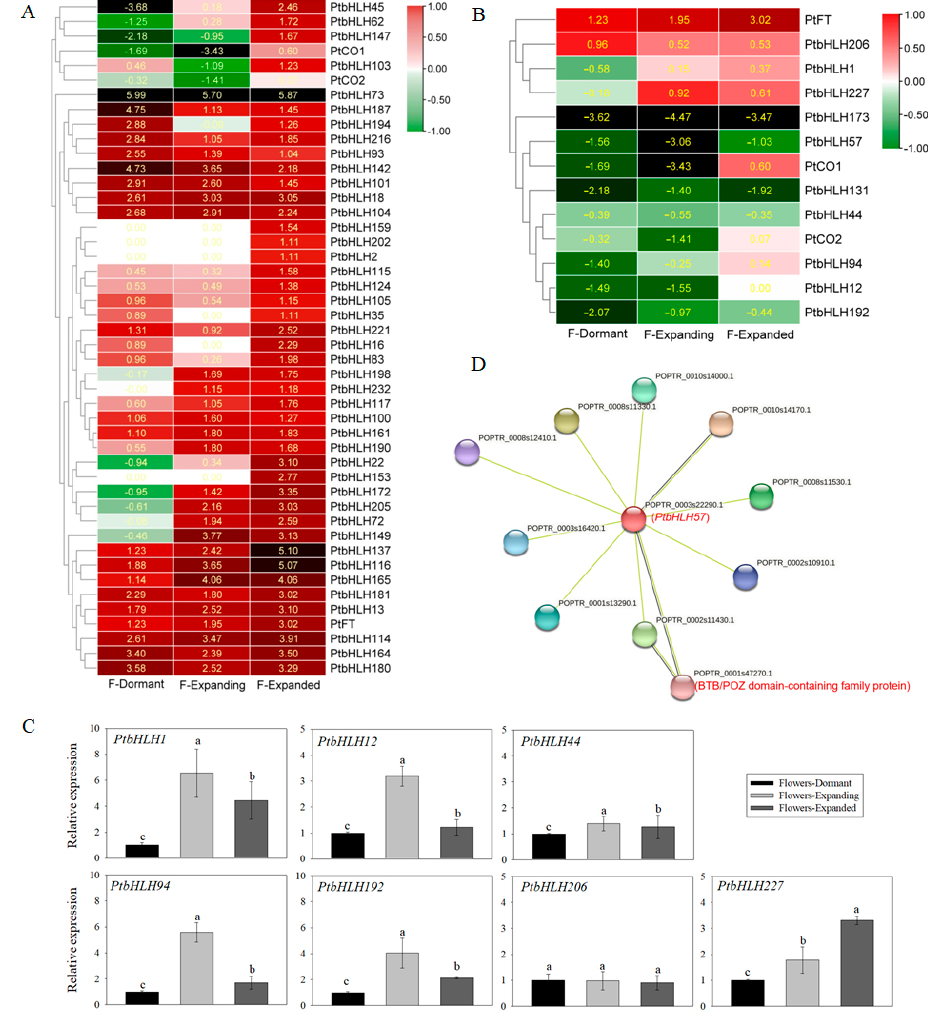
Figure 6. The expression pattern analysis of PtFBHs genes in the poplar flowering process. ( A ) The 43 significantly upregulated PtFBHs genes in Flowers-Expanded expression pattern analysis together with PtCO1 , PtCO2, and PtFT . ( B ) The 10 PtFBHs genes expression pattern analysis together with PtCO1 , PtCO2, and PtFT . ( C ) Expression analysis of PtbHLHs genes with qRT–PCRs. Error bars are standard errors of the mean from three technical replicates. The different letters indicates significant differences at p < 0.05 (Student’s t-test). ( D ) Protein interaction network of PtFBHs proteins.